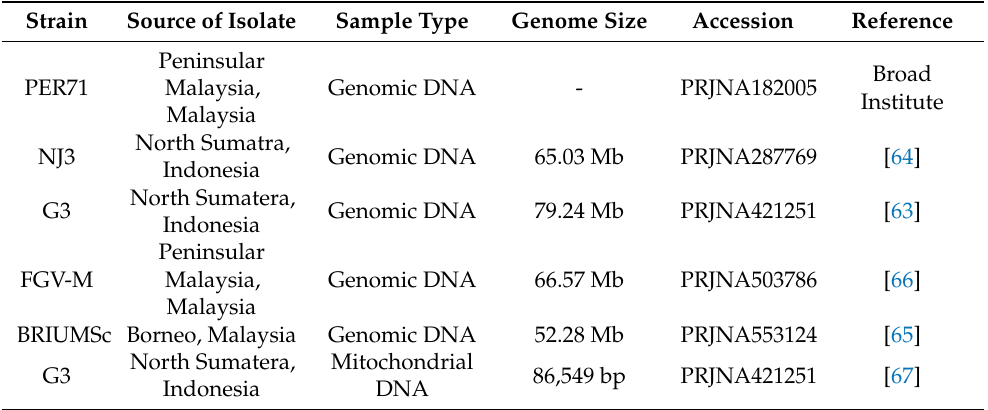
Table 1. Current whole genomic and mitochondria data of G. boninense available in the pub- lic